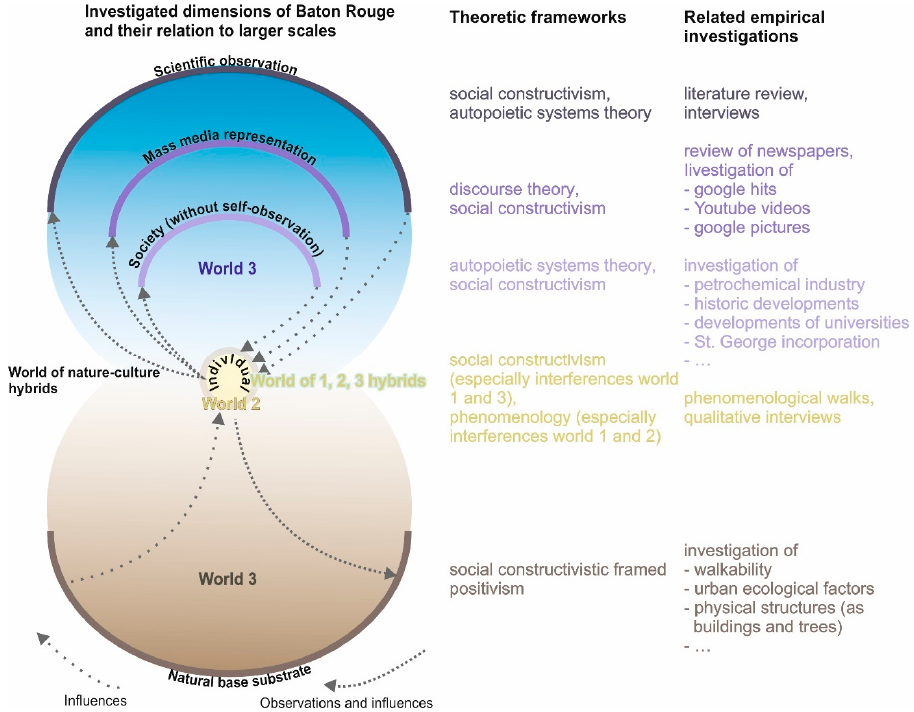
Figure 2. Schematic representation of the research design on neopragmatic approaches in terms of theoretical framing and methodological approach (own illustration [37]).